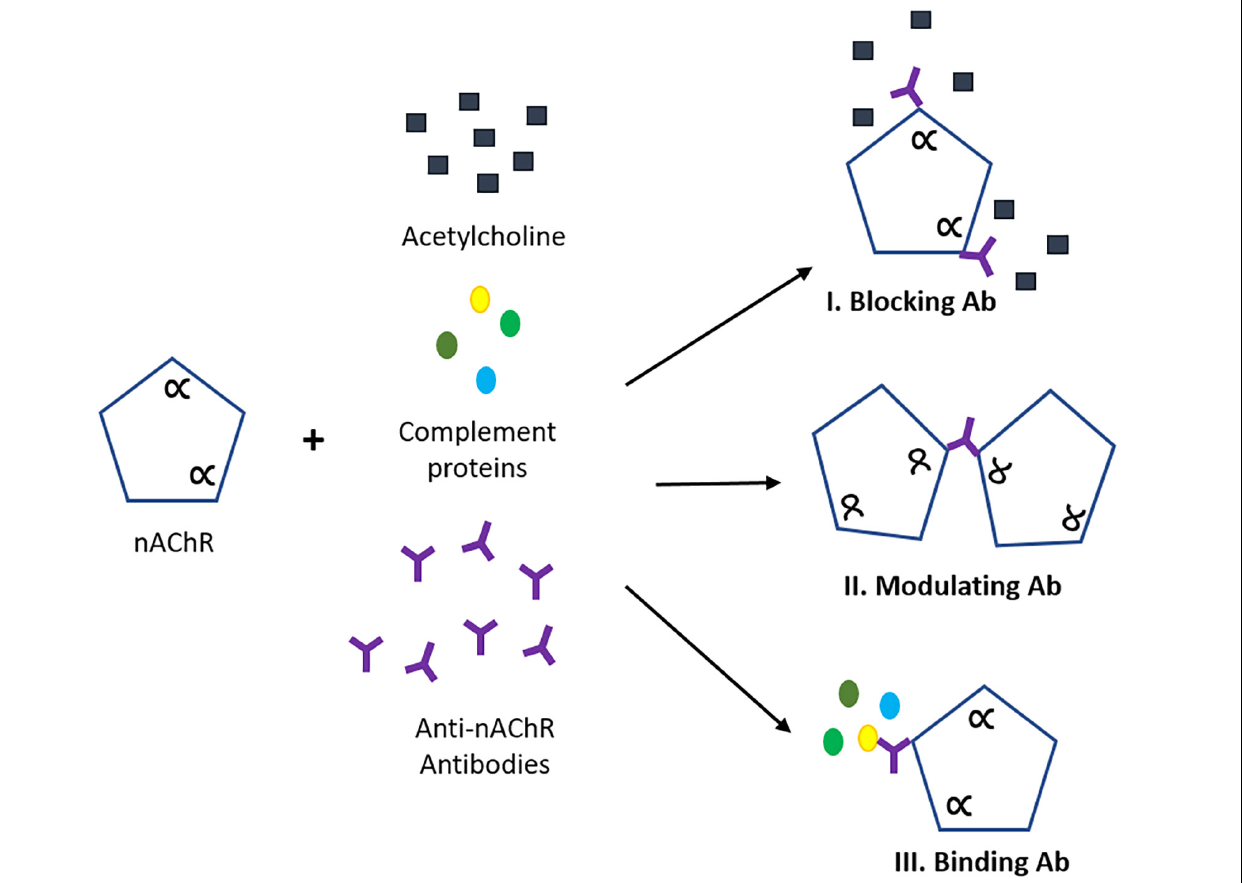
FIGURE 1 | Pathogenic mechanisms of anti-nAChR antibody (Ab). (I) Blocking abs interfere with ACh binding site interrupting neuromuscular transmission. (II) Modulating Abs that bind to two nAChRs causing receptor endocytosis leading to AChR degradation and reduction of expression. (III) Binding Abs that complex with a distinct location on the nAChR, triggering the activation of the complement cascade and subsequent formation of the membrane attack complex (MAC). Scheme adopted from Conti-Fine (Conti-Fine et al., 2006). The alpha ( α ) refers to the alpha subunit(s) on the